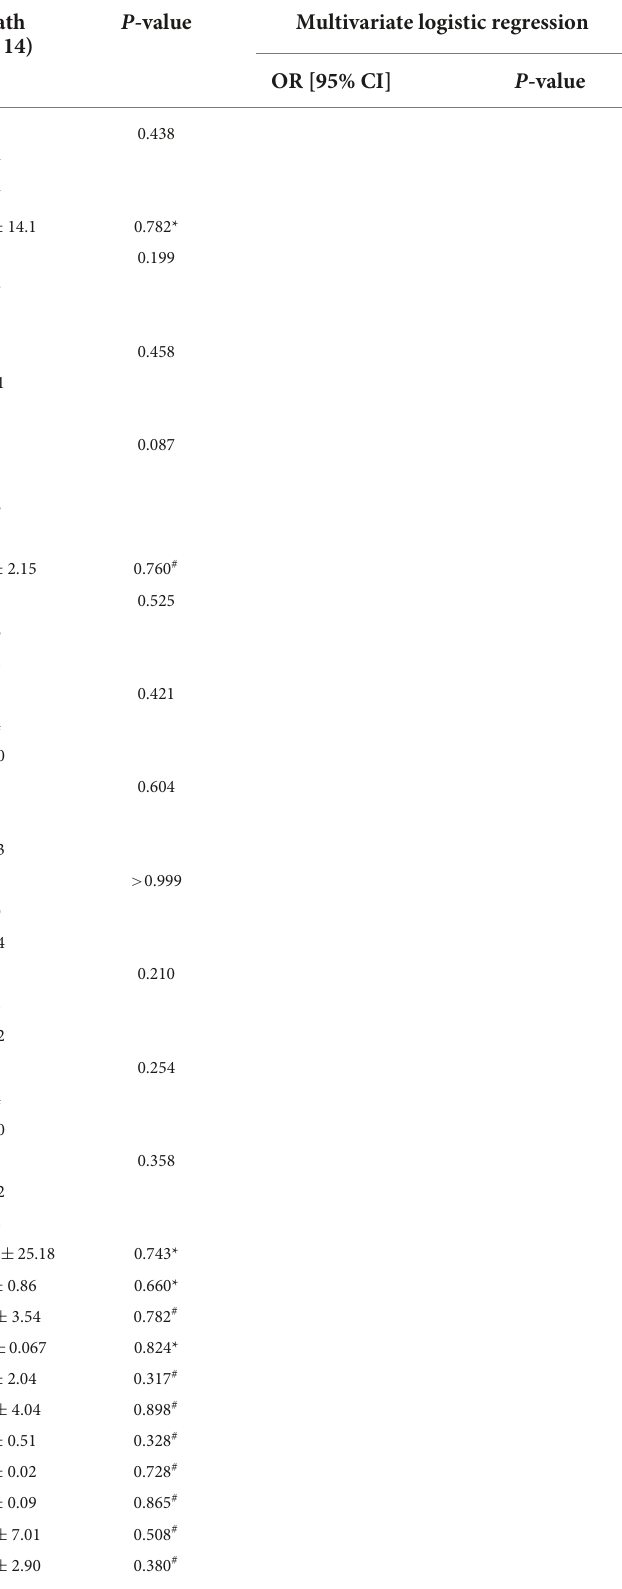
TABLE 2 Potential risk factors related to 6-month survival in severe SAH patients.